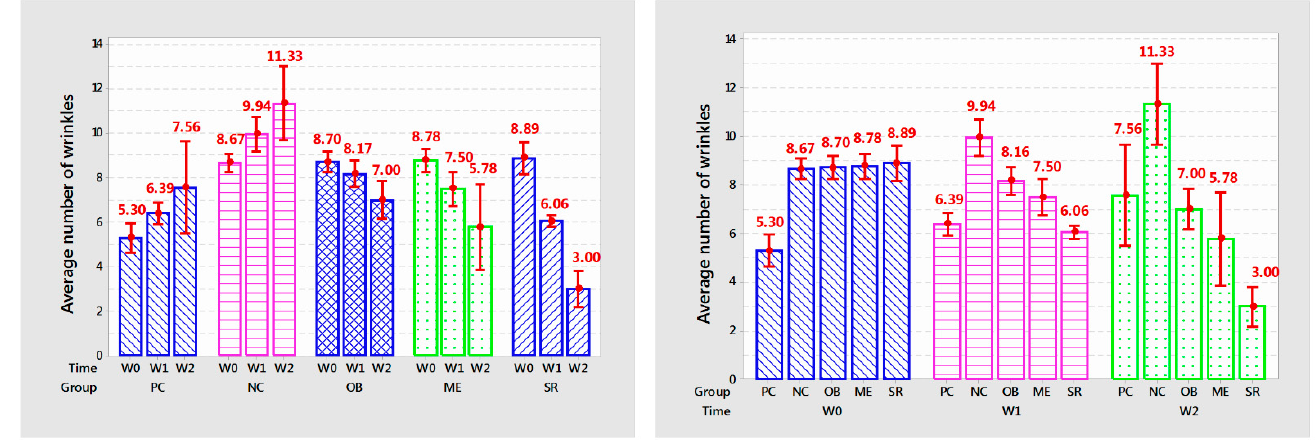
Figure 3. The graph shows the average number of wrinkles after each week of product applica- tion.